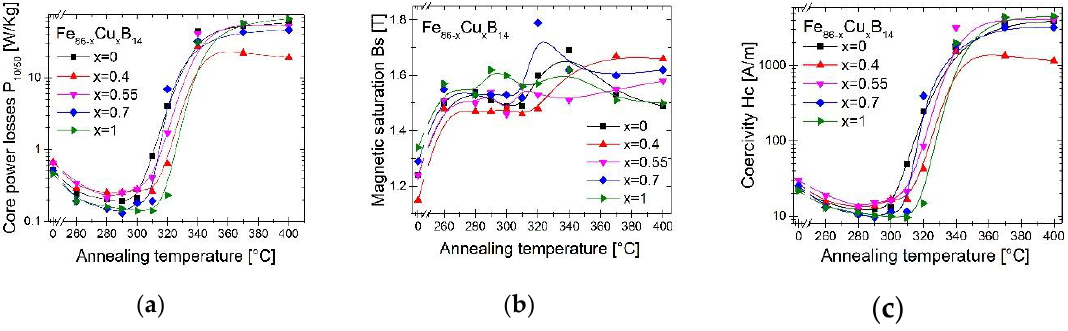
Figure 4. Core power losses P 10/50 ( a ), magnetic saturation Bs ( b ) and coercivity Hc ( c ) dependence on